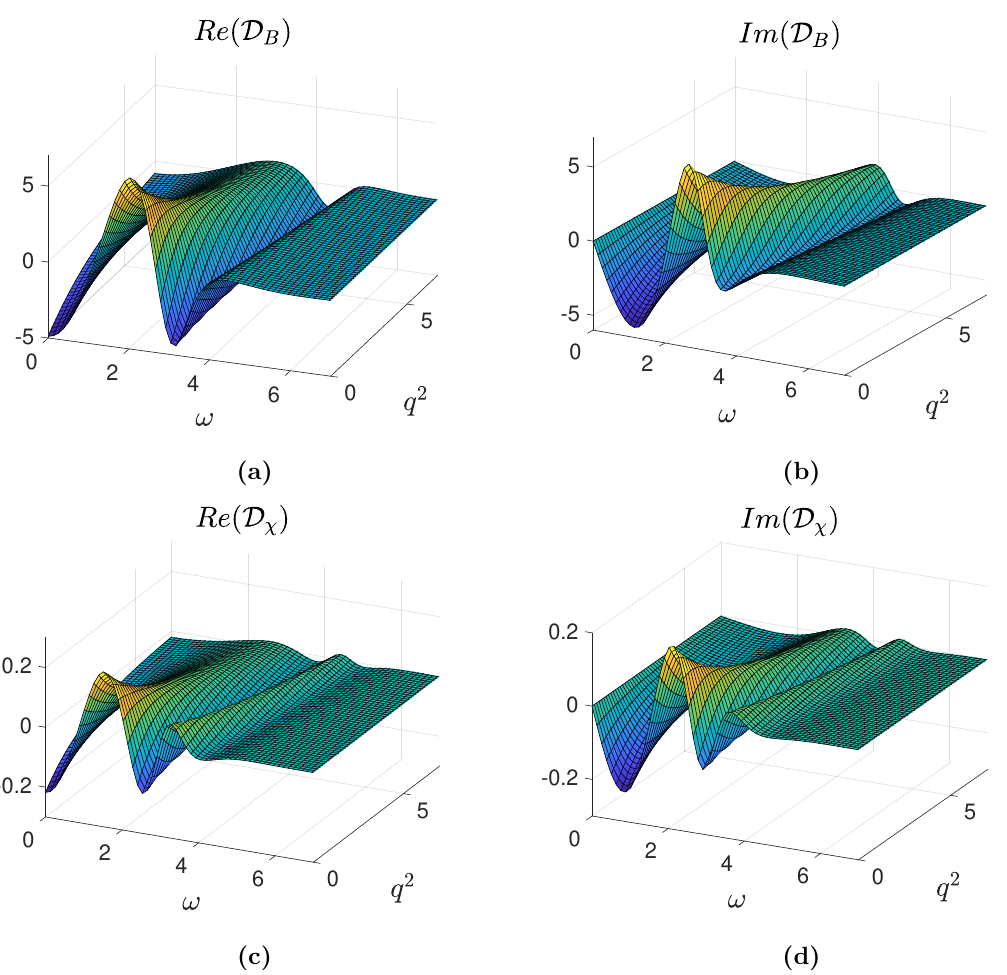
Figure 8. TCFs D B and D (cid:31) as functions of ! and q 2 when (cid:20) B = 0 : 25 and (cid:11) = 0.